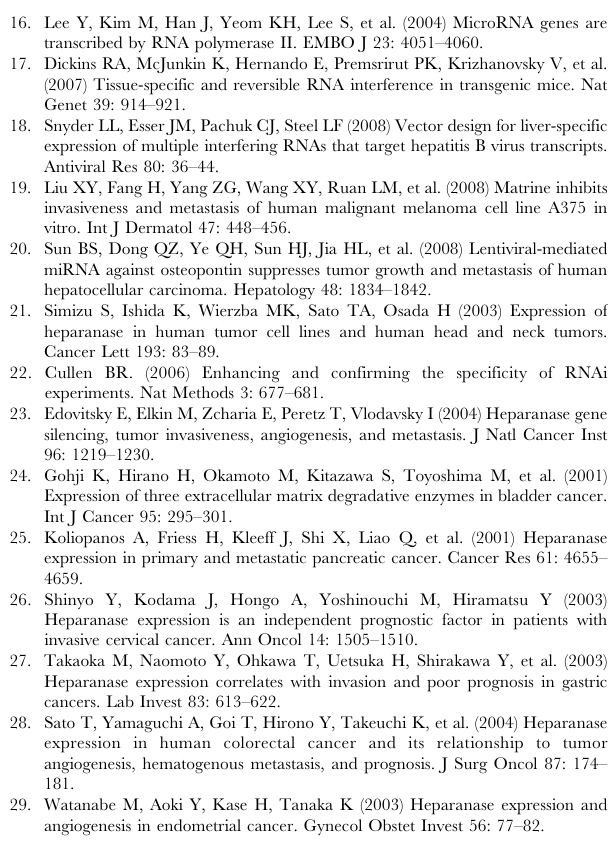
Figure S5 Schematic representation of the hypothetical molecular mechanisms, by which the HPSE miRNA regulates the expression of IL8 and CXCL1 and partic- ipates in the inhibition of melanoma migration and invasion. (A) Schematic diagram of the HPSE-induced IL8/ CXCL1/MAPK pathway. (B) The HPSE miRNA blocked the expression of IL8 and CXCL1 and participated in the inhibition of melanoma migration and invasion. (C) Schematic drawing of distant metastasis of melanoma induced by IL8 or